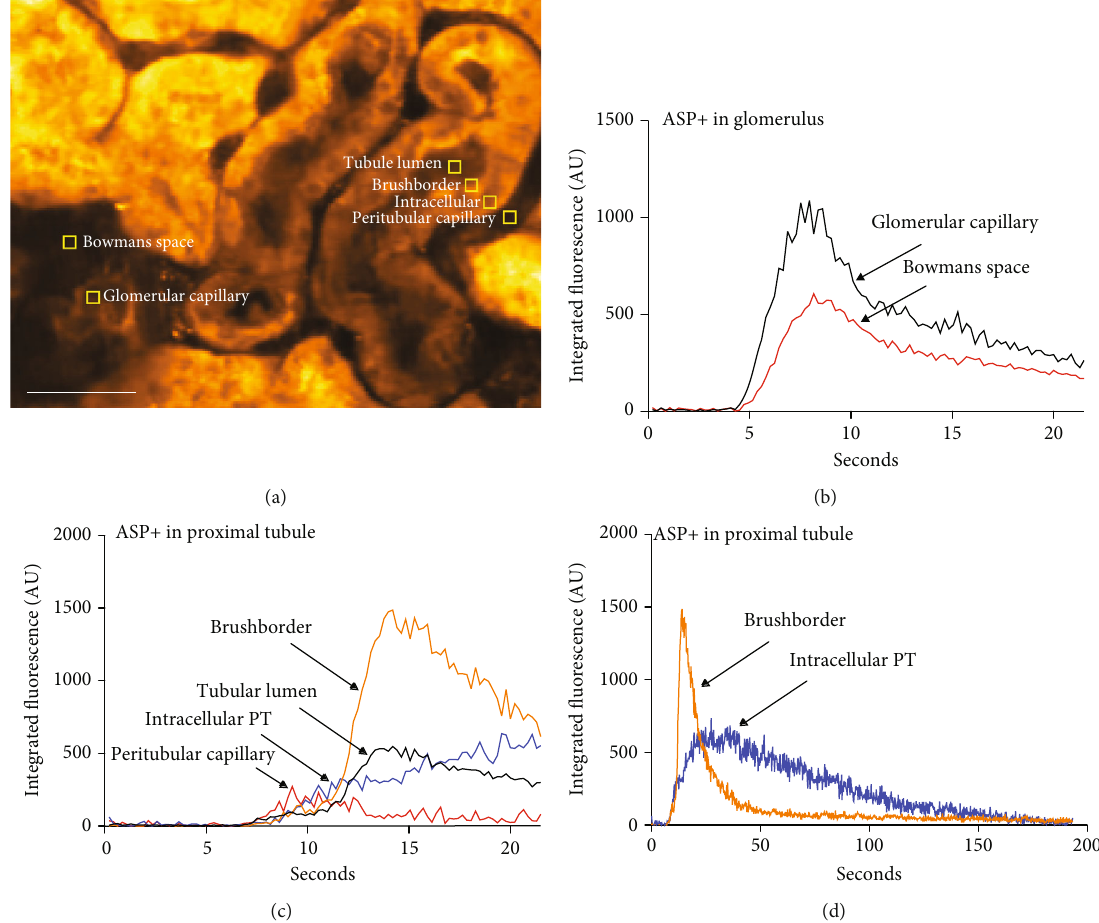
Figure 1: Quantitation of ASP+ signal appearance. (a) 6 ROIs ( 5 × 5 pixels) were placed in well-de fi ned locations within the tissue. The ASP + signal (after subtraction of background signal at t = 0 ) was recorded 5 times per second in each ROI for 21.5s. Scale bar: 50 μ m. (b) Time course of ASP+ signal intensity in the ROIs located in renal corpuscle within the fi rst 21 seconds. The signal increases in the capillary shortly earlier than in Bowman ’ s space re fl ecting fi ltration of ASP+ from plasma to primary urine. The passage of the bolus is seen as a peak with a tail in both compartments. (c) Time course (initial 21 seconds) of the ASP+ signal intensity in the ROIs located in the proximal tubule. The signal almost simultaneously increases in the peritubular capillary and intracellularly in the proximal tubular cell. In the capillary, the signal appears as a small peak, whereas in the cell, the signal appears as a steady increase. A few seconds later, a strong signal appears in the tubular lumen and the brushborder. In these locations, the signal appears as a short peak with a tail. (d) Complete time course (app 3 min) of the ASP+ signal intensity in the ROIs located intracellularly and in the brushborder of the proximal tubules. The peak in the brushborder lasts much shorter than the peak of intracellular signal, which shows a long